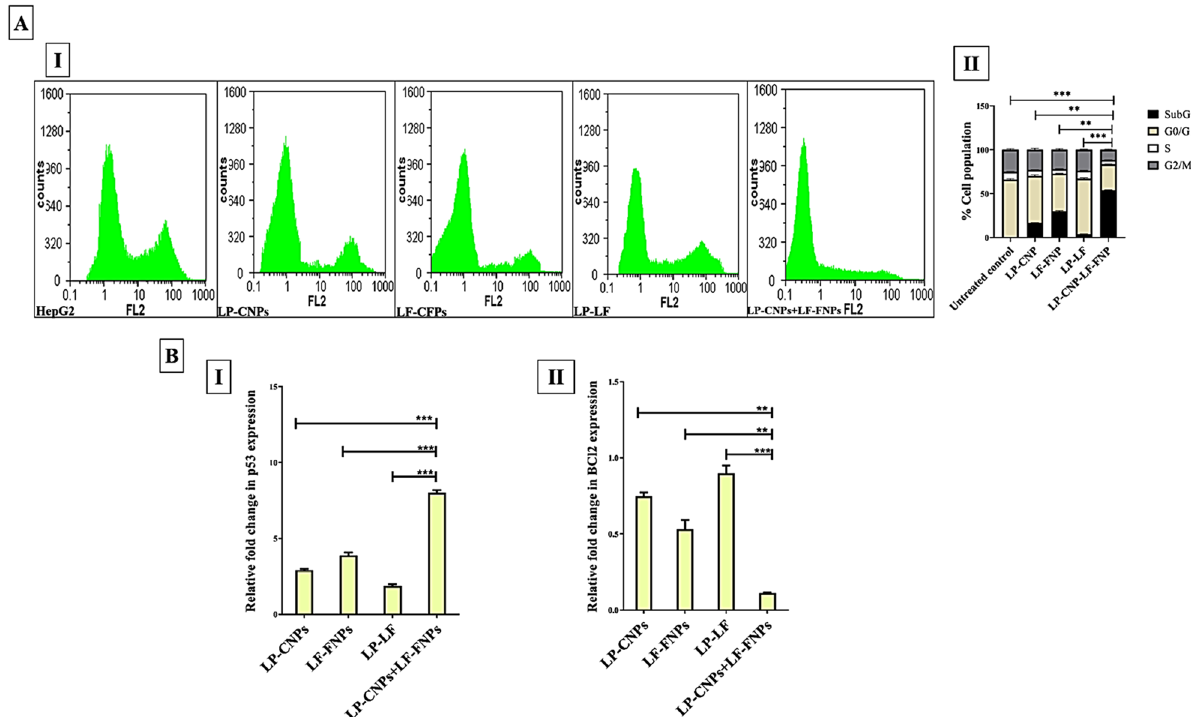
Figure 4. Alteration in cell cycle phases and in gene expression after treatment with the most effective anticancer nanoformulas and LP + LF. ( A ) Flow cytometry of cell cycle changes in treated HepG2 cells; ( I ) cell cycle charts with (II) percentages of cell populations in G0, G1, S, and G2/M. All values are demonstrated as mean ± S.E. LP-CNPs + LF-FNPs were compared to other formulas at G0 phase and statistically significant at p < 0.05*, p < 0.005**, p < 0.0005***. ( B ) Relative fold change in expression of ( I ) p53 and ( II ) BCl2 in MCF7 cells treated with LP-CNPs, LF-FNPs, LF-LP or LP-CNPs + LF-FNPs. All values are demonstrated as mean ± S.E. LP-CNPs + LF-FNPs are statistically significant with other formulas at p < 0.05*, p < 0.005**, p < 0.0005***. CNPs: CuO nanoparticles; FNPs: iron nanoparticles; LF: lactoferrin; LP: